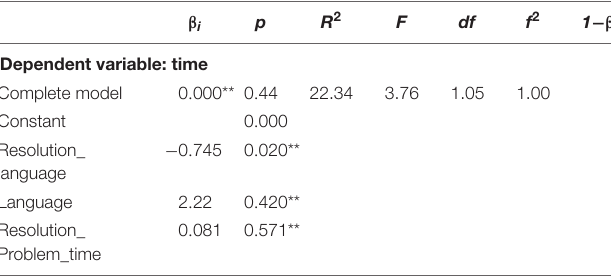
TABLE 2 | Summary of the results of the multiple linear regression with all the predictor